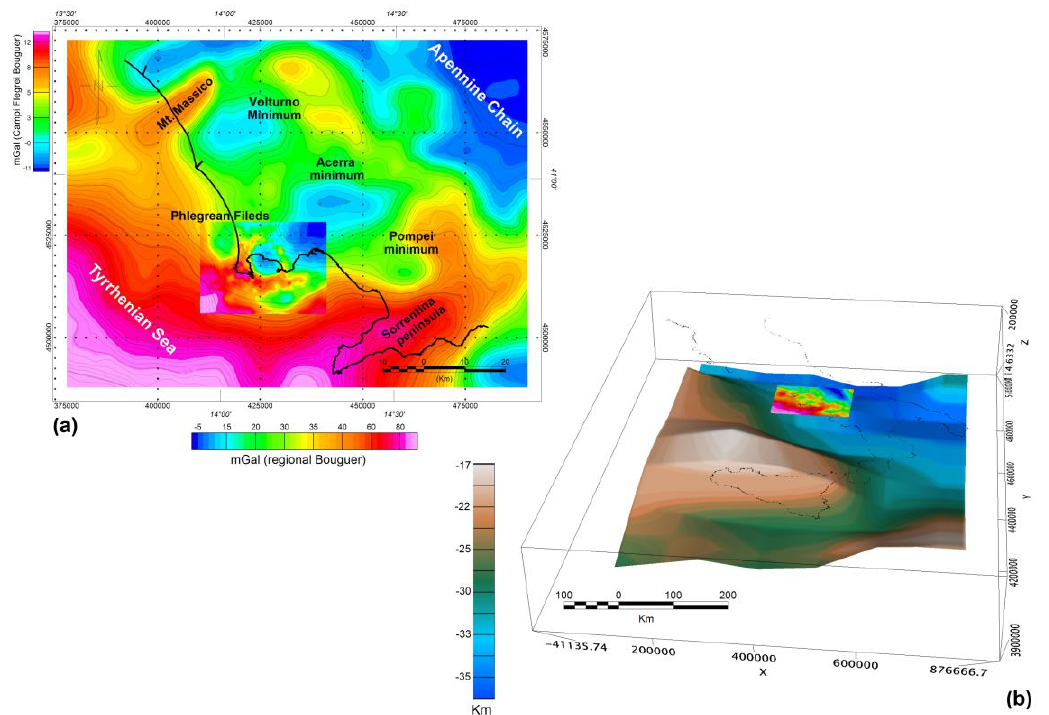
Figure 3. Overlay of the CFc VPmg Residual Bouguer anomaly (small box inside the map ( a )) onto the regional ISPRA Bouguer map ( b ). Regional ISPRA Bouguer map displayed on the 3D representation of the Moho depth (km) of the southeastern Tyrrhenian sea as derived by the CRUST1 model [63,64], southern point of view.